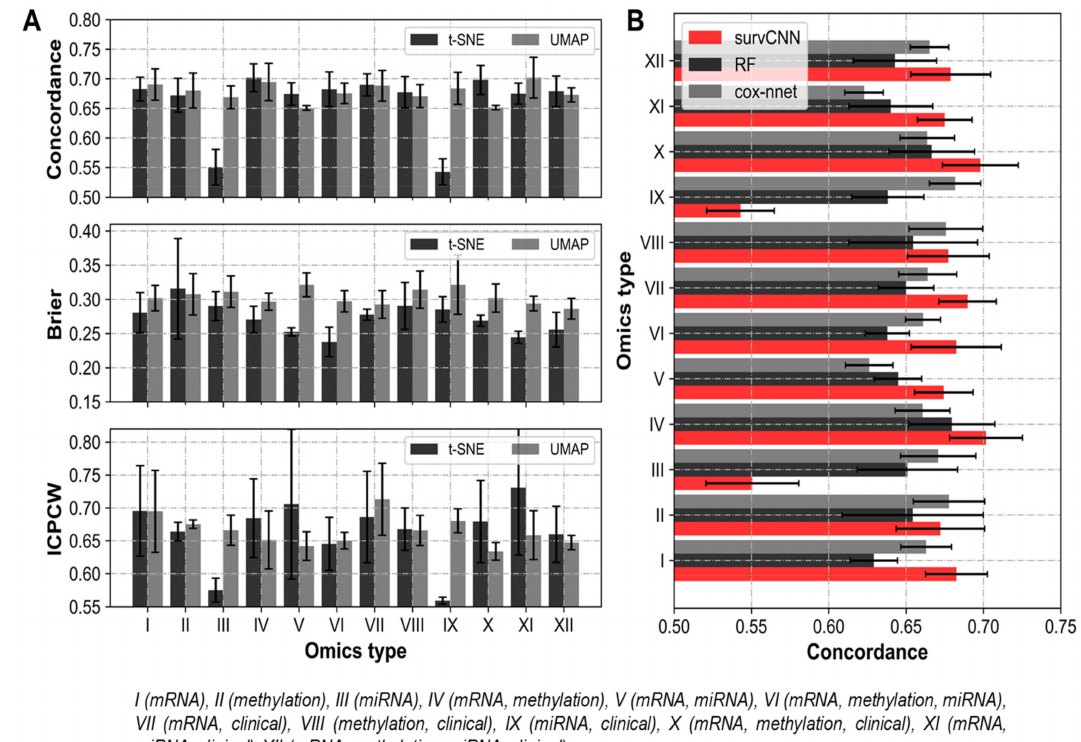
Figure 5. Overall performance of proposed workflow on different metrics of performance and projection algorithm. ( A ) Performance in terms of C-Index, Brier score and ICPCW ( B ) SurvCNN outperforms competing methods on nine out of twelve omics combinations